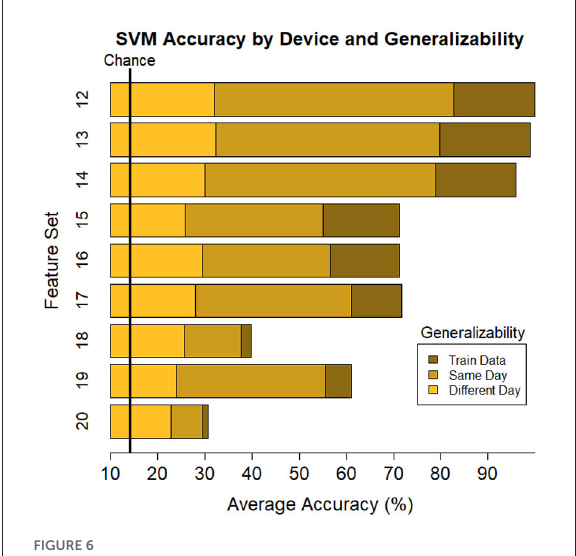
FIGURE6 Plot of summary of individuals’ classifier accuracy to predict type of task(s): T, C, M, T+C, T+M, C+M, T+C+M, for each feature subset outlined in Table 5. Numeric averages are provided in Table 5. The number of features decreases from top (Set #12) to bottom (Set #20) in a nonlinear fashion, see Table 5 # of features . Chance performance was 1 of 7 (14.3%). Set number refers to the electrode and bandwidth pairs included in the feature set used for classification. Same day refers to the average score across both classifier Index 1 and 2 (Table 2) such that Day 1 or Day 2 was both used for training and testing the model. Different day refers to the average score across both classifiers Index 3 and 4 (Table 2). In model Index 3, Day 1 was used for training and Day 2 was used for testing. In model Index 4, Day 2 was used for training and Day 1 was used for